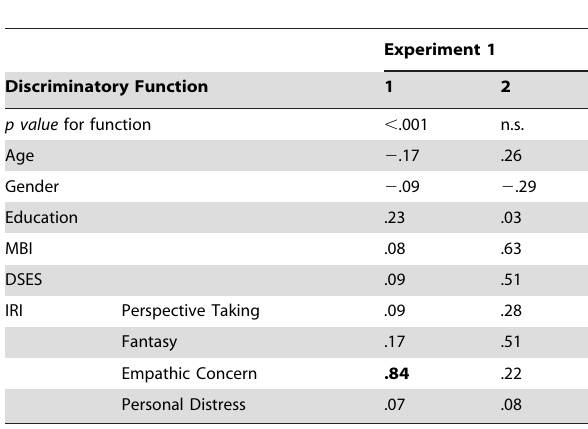
Table 3. Loading matrix of correlations for discriminant analyses conducted in Experiments 1.